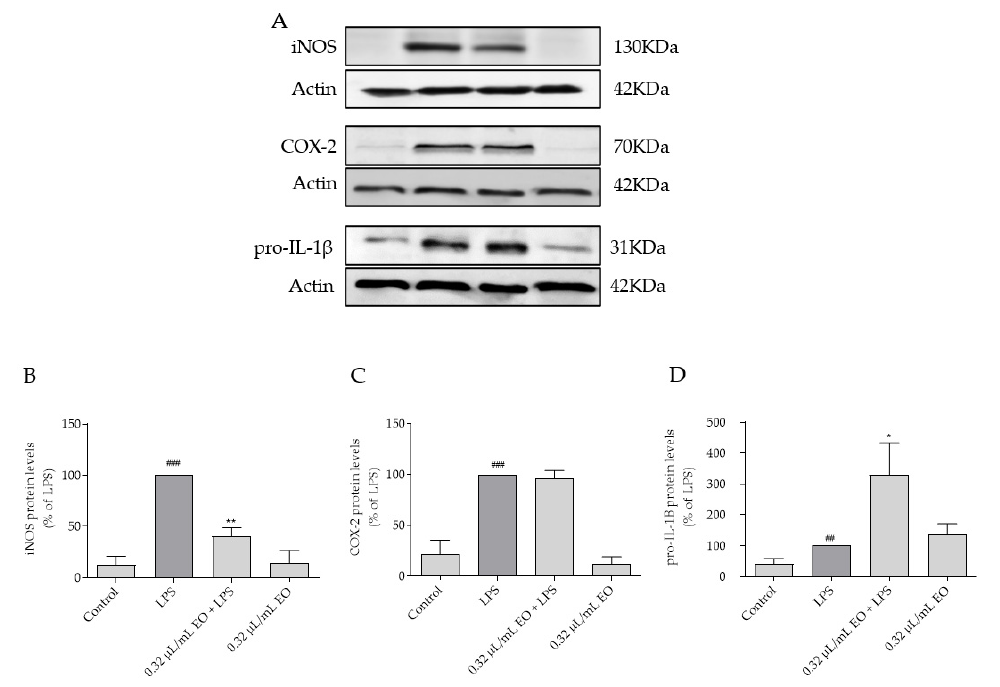
Figure 5. Inhibitory effect of Lavandula luisieri essential oil (EO) on LPS-induced inflammatory proteins. ( A ) Representative Western blots of iNOS, COX-2 and pro-IL-1 β . Quantification of ( B ) iNOS, ( C ) COX-2 and ( D ) pro-IL-1 β protein levels. Cells were maintained in culture medium (control), or incubated with 1 µ g/mL LPS, or incubated with the essential oil (0.32 µ L/mL) alone or simultaneously with 1 µ g/mL LPS, for 24 h. Results are expressed as percentage of protein levels relative to LPS. Each value represents the mean ± SEM from at least 3 experiments (## p < 0.01; ### p < 0.001, compared to control; * p < 0.05, ** p < 0.01, compared to LPS). Each value represents the mean ± SEM from three